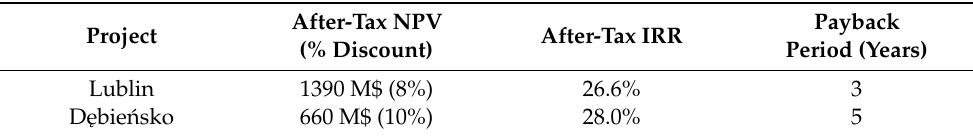
Table 6. Financial outcomes of the different projects.